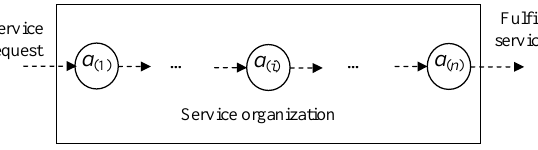
Fig. 9. Interaction task request-service mechanism queuing